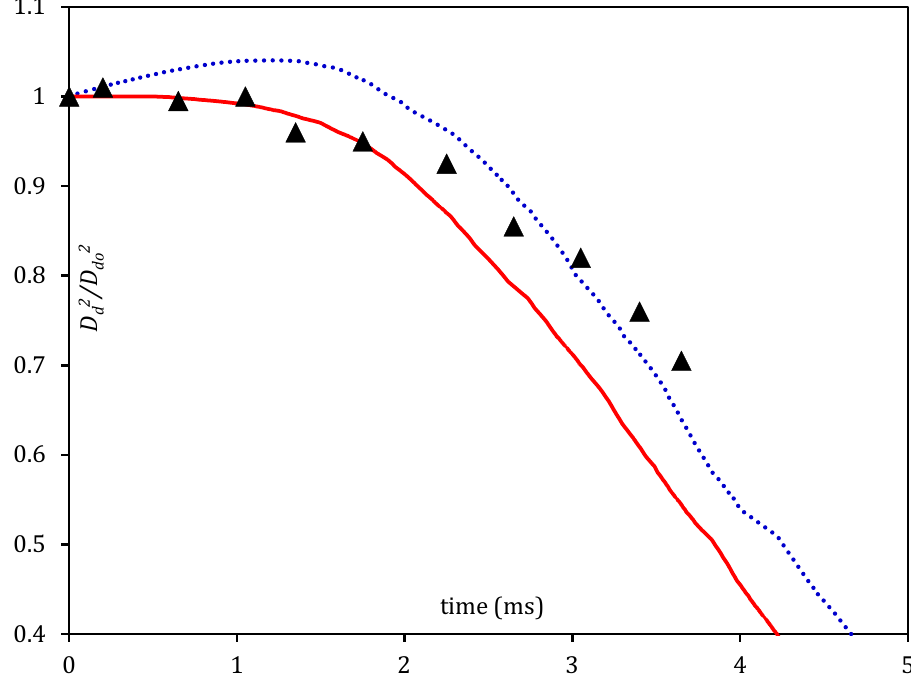
Figure 5. The validation of the models for the normalised squared droplet diameters predicted by the standard ANSYS Fluent (solid curve), and ANSYS Fluent incorporating the CFSM (dotted curve), using data reported in [48] (bold triangles) for kerosene fuel.